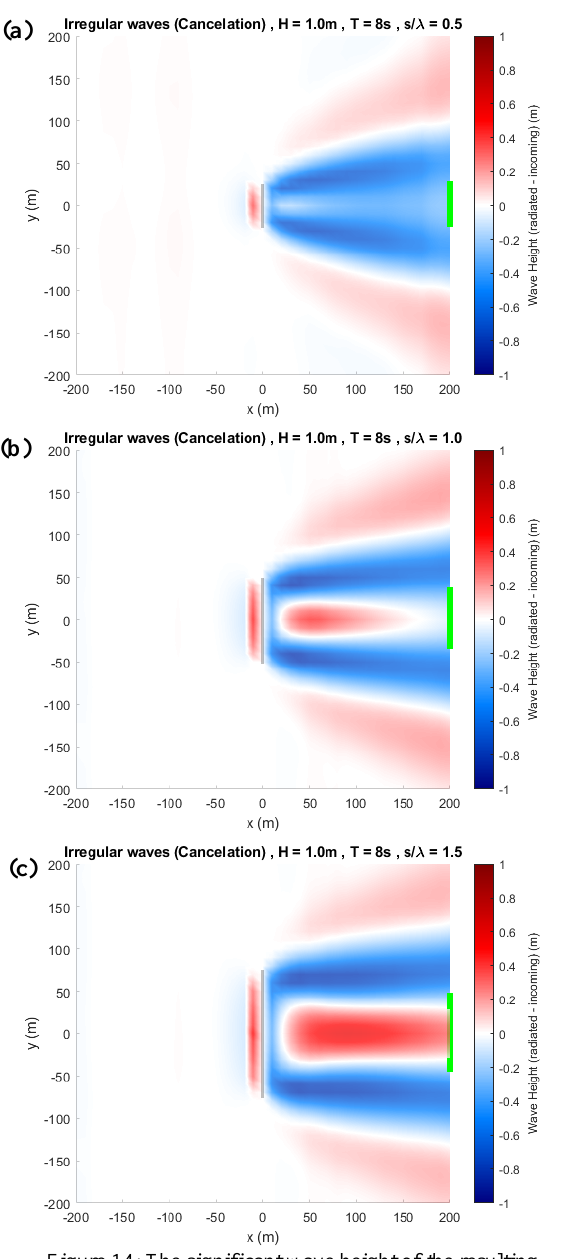
Figure 14: The significant wave height of the resulting (cancelation) wave field assuming irregular wave condition for different spans, (a) 𝑠 𝜆⁄ = 0.5 , (b) 𝑠 𝜆⁄ = 1.0 , and (c) 𝑠 𝜆⁄ = 1.5 . Green solid line represented the capture width.